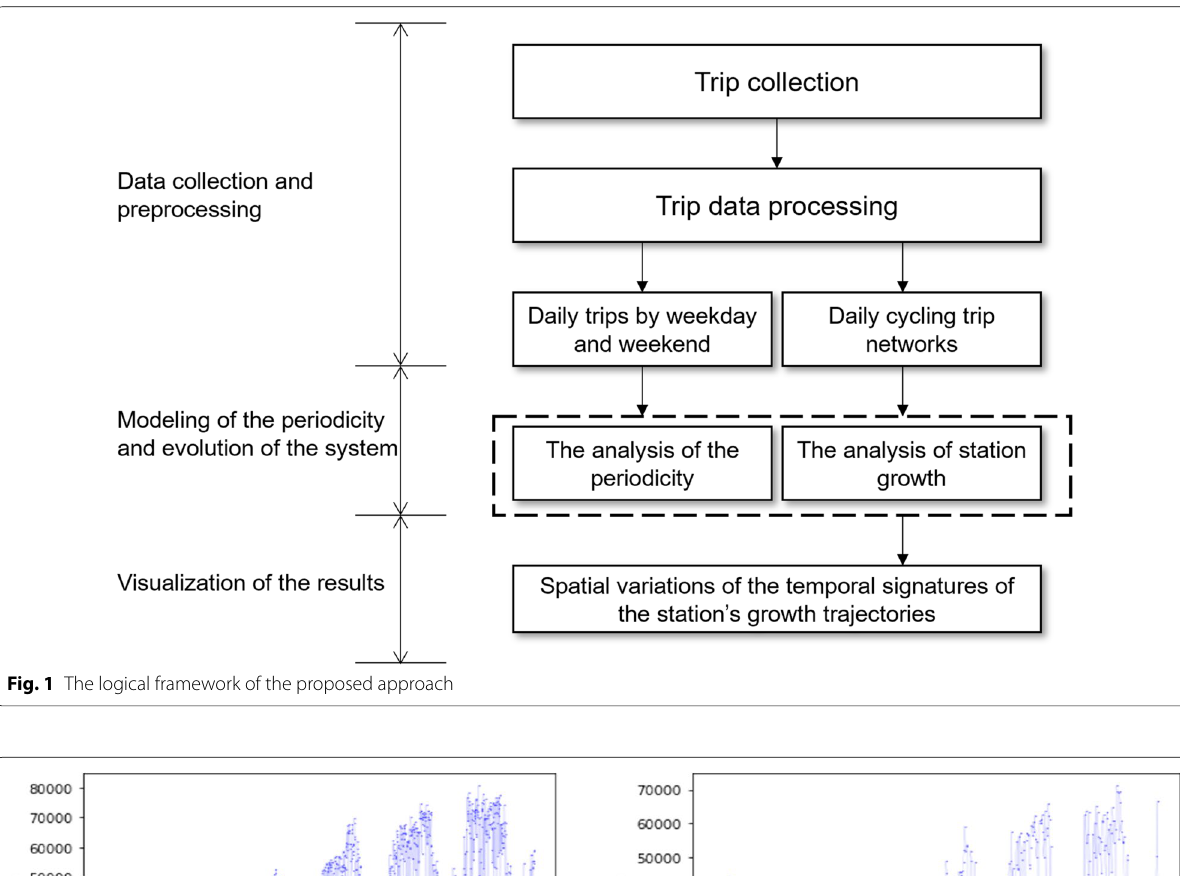
Fig. 1 The logical framework of the proposed approach